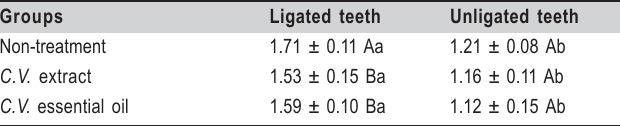
Table 1. Means and standard deviation of alveolar bone loss [mm] for ligated and unligated teeth in all experimental